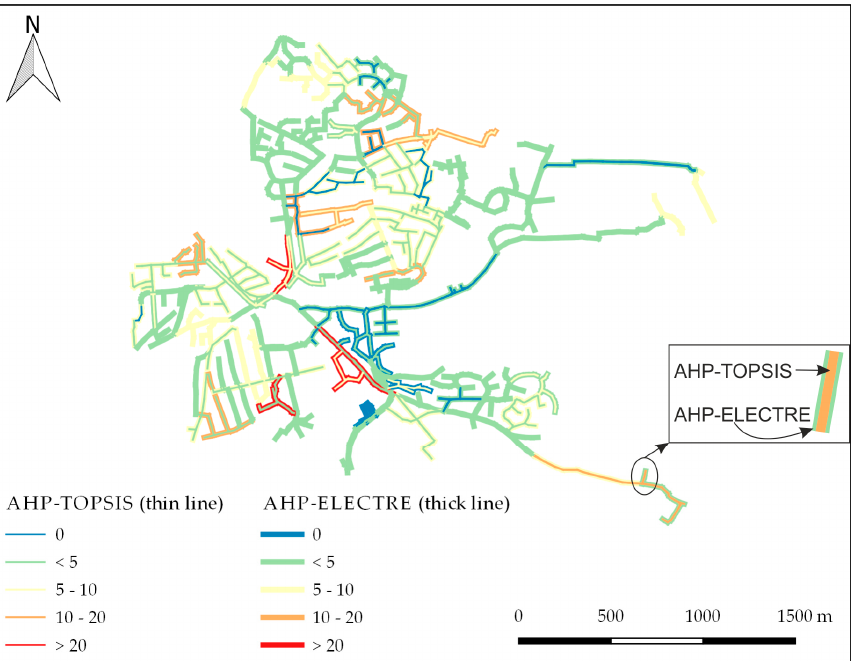
Figure 7. Comparison of the rankings of the sewer system between TOPSIS (thin line) and ELECTRE (thick line) with the results from AHP.